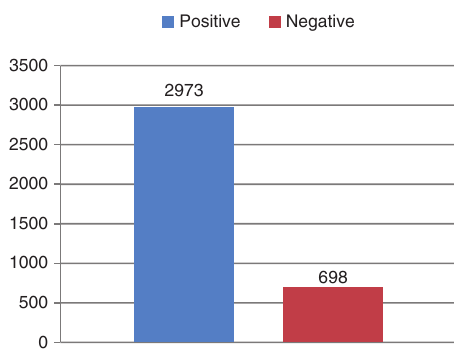
Figure 6: Results of polarity analysis.